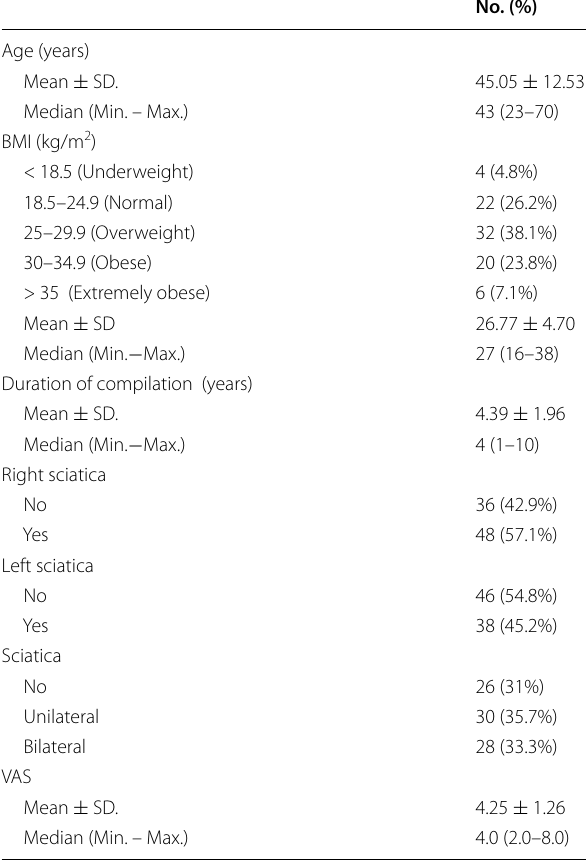
Table 1 Distribution of the studied cases according to different parameters (n 84) =